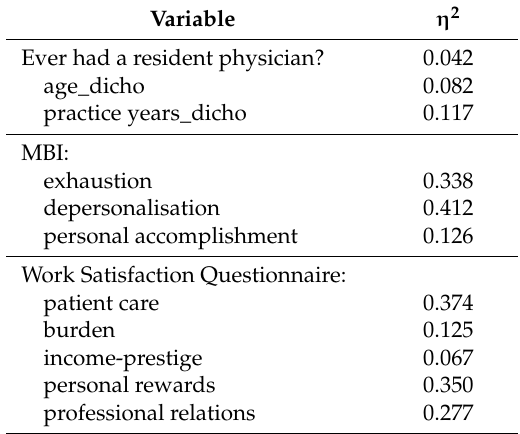
Table 2. Contribution of classification variables to cluster formation indicated by effect size η 2